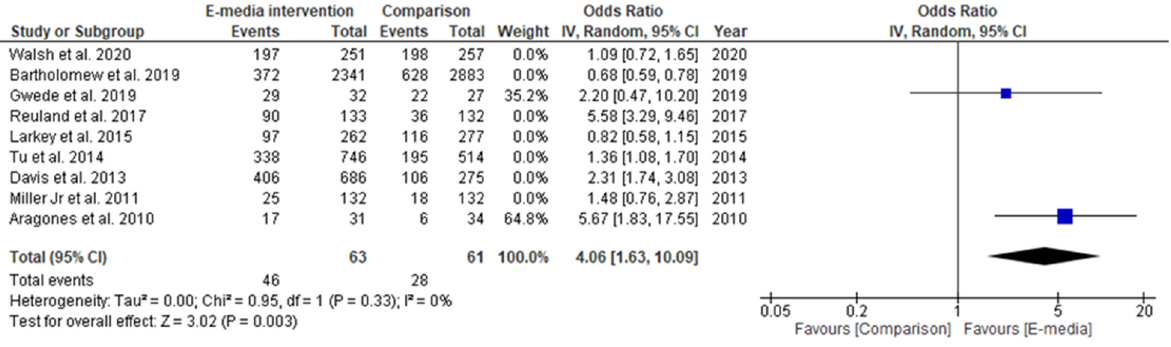
Figure 7. Random-effects forest plot for studies targeting Latino populations ( n = 2). Box size represents study weighting. Diamond represents overall effect size and 95% CI.